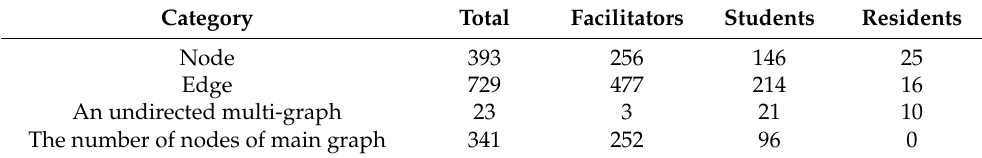
Table 9. Overview of network graph analysis of words appearing more than twice (3-g). Category Total